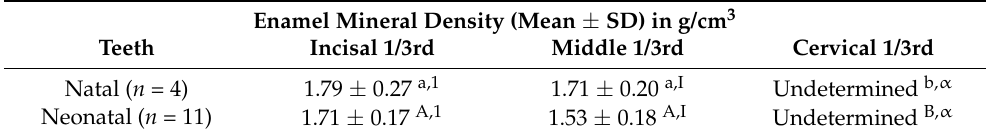
Table 2. Enamel mineral density (in g/cm 3 ) at incisal, middle, and cervical thirds of natal/neonatal